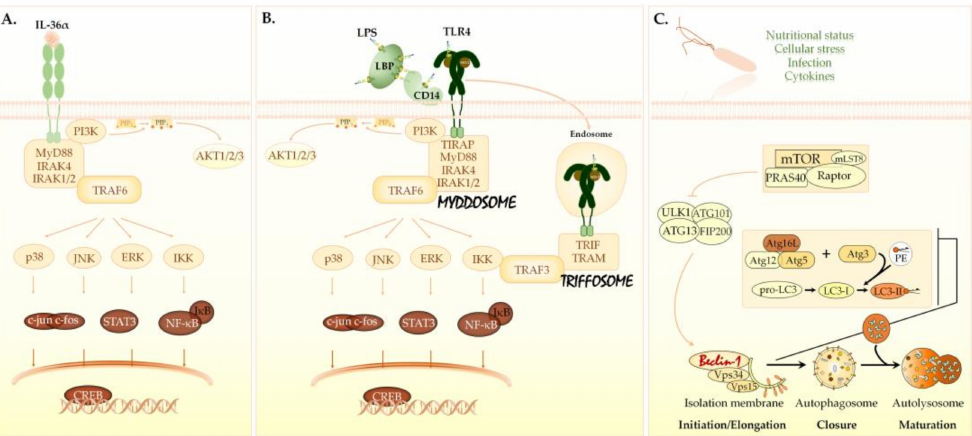
Figure 1. Signaling pathways triggered by IL-36 α , LPS, and autophagy inducers. ( A ) The IL-36 α signaling pathway. IL-36 α / β / γ bind to the IL-36R (IL-1Rrp2) and use the IL-1 receptor accessory protein (IL-1RAcP) as a co-receptor. Following ligand binding, the TIR domain—located in the intracellular portion of the IL-36R:IL-1RAcP heterodimer—recruits MyD88 adaptor protein, which in turn interacts with IRAKs and TRAF-6. The MyD88/IRAK/TRAF6 platform activates AP-1, CREB and NF- κ B transcription factors via IKK, ERKs, JNKs, and p38. ( B ) The LPS/TLR4 signaling pathway. LBP and CD14 bind and transfer LPS monomers to the TLR4/MD-2 heterodimer. The dimerized TIR domain in the cytoplasmic portion of TLR4 consecutively recruits TIRAP, MyD88, and IRAK proteins, thus leading to the assembly of a supramolecular complex termed the myddosome. The LPS-TLR4/MD2 complexes can also be internalized into endosomes. The TIR domain of endosomal TLR4 binds TRAM, which attracts TRIF resulting in the formation of another complex called the triffosome. Myddosomes and triffosomes recruit TRAF6 or TRAF3 and activate AP-1, NF- κ B, CREB, and IRF-3 via MAPKs, IKK, and PI3K. ( C ) The autophagy-related signaling pathway. The major element in the regulation of autophagy is the mTORC1. Besides mTOR, mTORC1 is comprised of the Raptor and mLST8 molecules. The non-core components associated with mTORC1 include PRAS40 and DEPTOR. Autophagy inducers inhibit mTORC1, and thereby activate the autophagic cascade. Inhibition of mTORC1 results in the consecutive activation of the ULK1 and PI3KC3 complexes. The PI3KC3 complex contains Beclin-1 protein. The activated PI3KC3 induces local production of PI3P at the endoplasmic reticulum membrane and thereby promotes the generation of an omegasome from which the isolation membrane is generated. PI3P recruits two ubiquitin-like conjugation systems, the ATG12–ATG5-ATG16L1 and ATG7/ATG3 complexes, to the omegasome. ATG3 forms a covalent bond between the membrane-resident phosphatidylethanolamine and the microtubule-associated protein 1 light chain 3B-I (LC3B-I) protein. The ATG12–ATG5-ATG16L1 complex enhances the ATG3-mediated conjugation of LC3B-I. The lipidated LC3B protein is termed LC3B-II. LC3B-II is essential for the elongation and closure of the phagophore membrane, trafficking of the autophagosomes, and their fusion with lysosomes. AP-1, activator protein 1; CREB, cAMP response element-binding protein; DEPTOR, DEP-domain containing mTOR-interacting protein; ERKs, extracellular signal-regulated kinases; IKK, I κ B kinase; IRAKs, IL-1 receptor-associated kinases; IRF-3, interferon regulatory factor 3; JNKs, c-Jun N-terminal kinases; LBP, LPS-binding protein; MD-2, myeloid differentiation factor 2; mLST8, mLST8; mammalian lethal with sec-13 protein 8; mTOR, mechanistic target of rapamycin; mTORC1, mTOR complex 1; MyD88, myeloid differentiation primary response 88; NF- κ B, nuclear factor- κ B; PE, phosphatidylethanolamine; PI3K, class I phosphatidylinositol 3-kinase; PI3KC3, class III phosphatidylinositol 3-kinase; PI3P, phosphatidylinositol-3-phosphate; PRAS40, proline-rich Akt substrate of 40 kDa; Raptor, regulatory-associated protein of mTOR; TIR, Toll/IL-1 receptor domain; TLR4, Toll-like receptor 4; TRAF-6, tumor necrosis factor receptor-associated kinase 6; TRAM, TRIF-related adaptor molecule; TRIF; TIR domain-containing adaptor-inducing interferon- β ; ULK1, Unc-51-like kinase 1; WIPI, WD repeat domain phosphoinositide-interacting